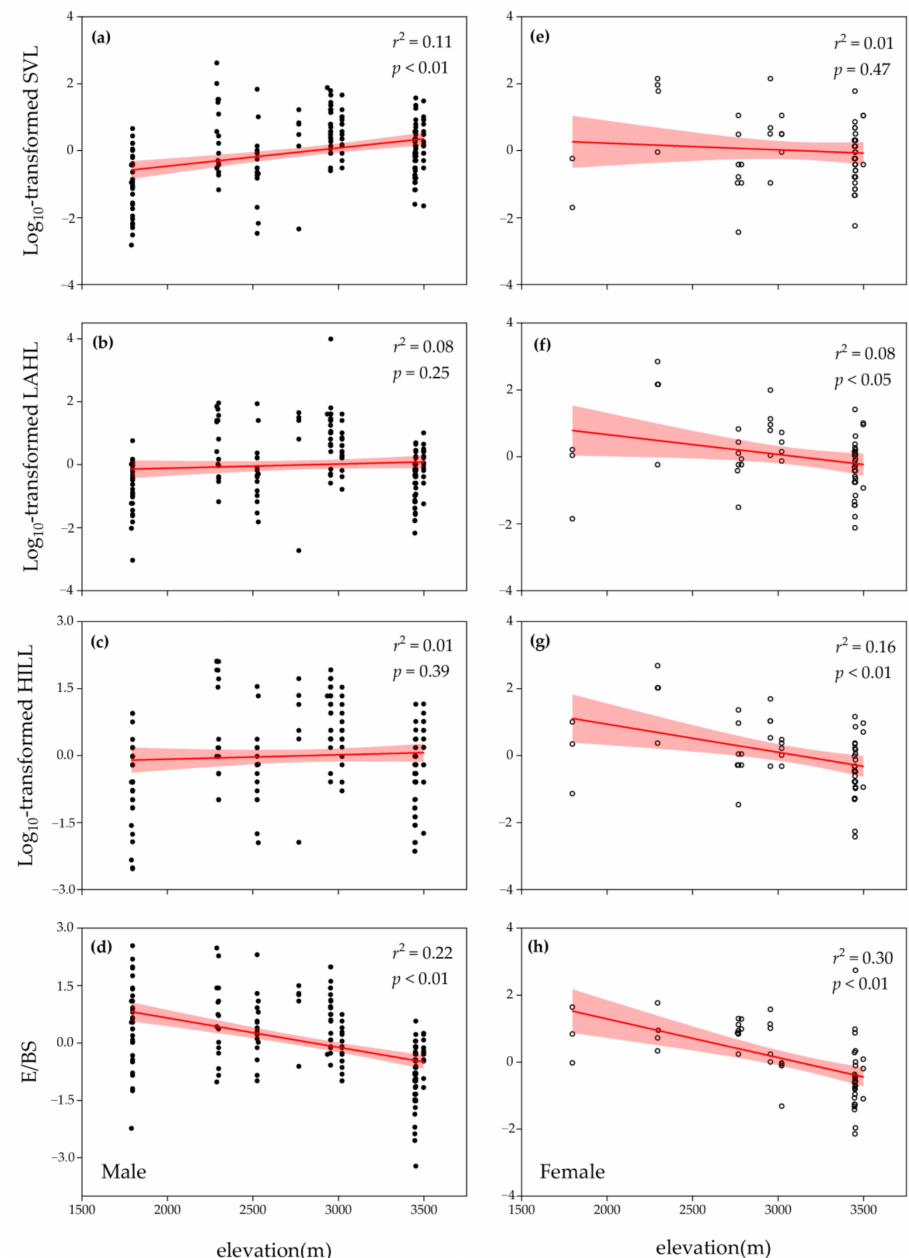
Figure 3. Variation in Rana kukunoris morphometrics along an elevational gradient on the eastern margin of the Qinghai–Tibetan Plateau. Linear regressions for each morphometric and age were used to control the effect of age in both sexes. The standardized residuals from the regression were used in another linear regression against elevation. Results are presented in r 2 and p , respectively. Filled circles represent male data and empty circles represent female data. ( a , e ) Log 10 -transformed SVL; ( b , f ) log 10 -transformed LAHL; ( c , g ) log 10 -transformed HILL; ( d , h ) extremities to body size